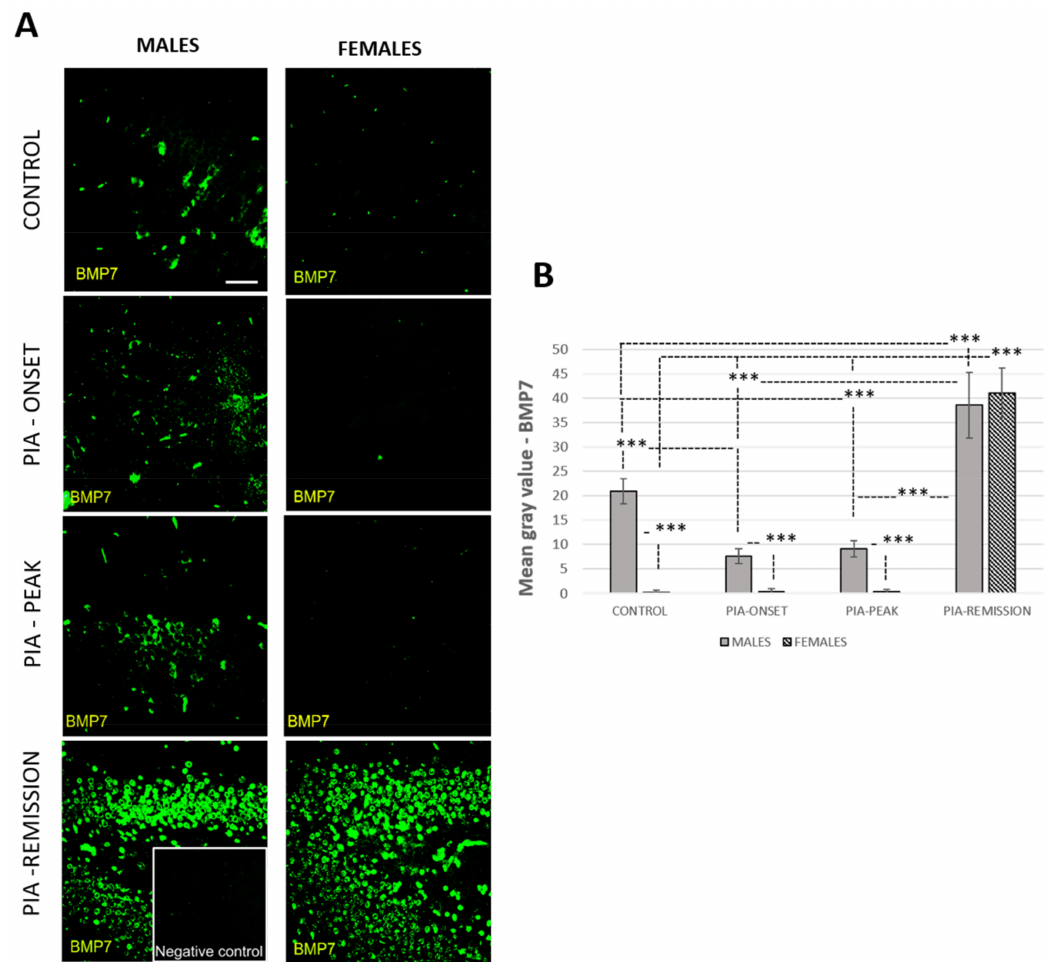
Figure 4. Pristane-induced arthritis upregulates BMP-7 expression in the hippocampus/dentate gyrus in male rats. ( A ) Representative immunofluorescent pictures show staining with anti-BMP-7 antibody in paraffin-embedded sections of brain tissue obtained from male and female DA rats: control (treated with saline); PIA onset (between 9th and 12th day after induction); PIA peak (between 16th and 20th day after induction); PIA remission (between 20th and 25th day after induction). ( B ) BMP-7 immunoreactivity in the hippocampus/dentate gyrus. The immunofluorescent signal quantification was performed using Cell F v3.1 software analysis on 12 regions of interest (3 slides/rat × six animals/group). Values are expressed as mean grey value ± SD ( N = 24). One-way ANOVA followed by the post hoc Scheff é test: *** p < 0.001. Insert shows staining in a slide incubated without primary anti-BMP7 antibody (negative control). Scale bars indicate 50 µ